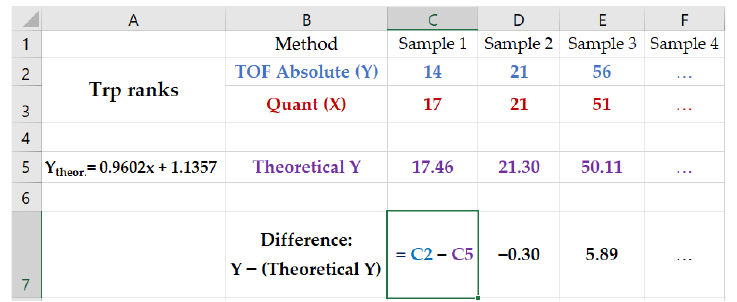
Figure 1. Computation of “diff” values. An exemplary Spearman correlation for Tryptophan (Trp) is calculated between TOF absolute and quant. The equation of the fitted regression line is shown on the left in field 5A. Note that this equation corresponds to the equations of regression given in Figure 2. From the assigned TOF absolute ranks (in blue), the theoretical ranks (i.e., the points on the regression line shown in purple) are subtracted, yielding the row “Difference”, which indicates the individual deviations from the regression